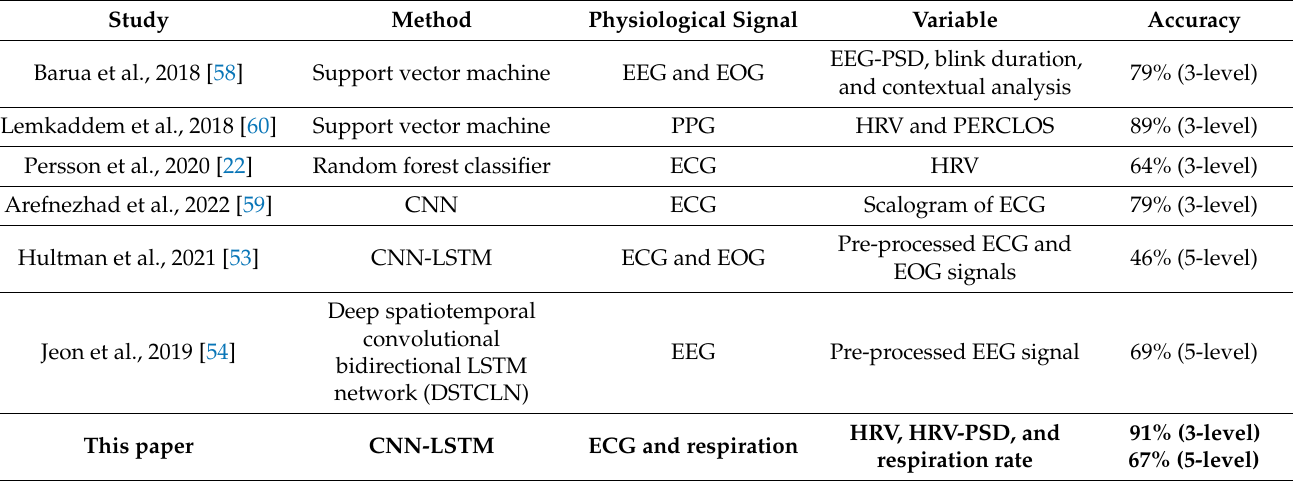
Table 4. Accuracy comparison of the proposed method with other multi-level drowsiness classifica- tion methods based on physiological